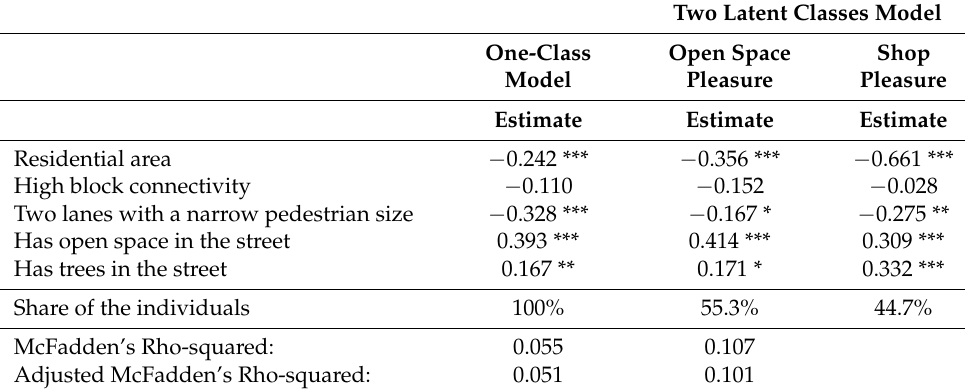
Table 4. Results for latent-class regression models ( happiness sense